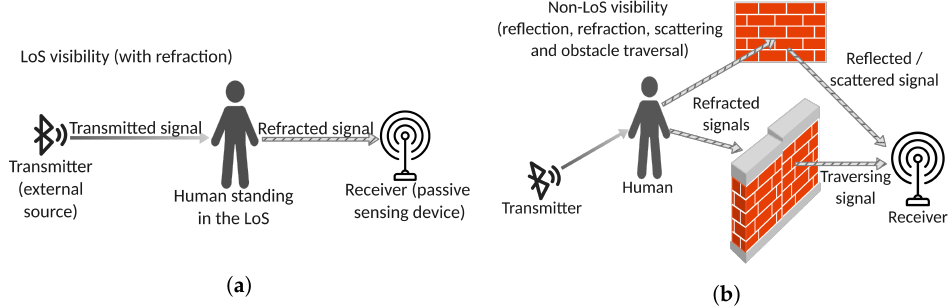
Figure 1. Line-of-Sight (LoS) visibility ( a ). Non-Line-of-Sight and through-the-wall visibility ( b ). This figure was adapted from [22].